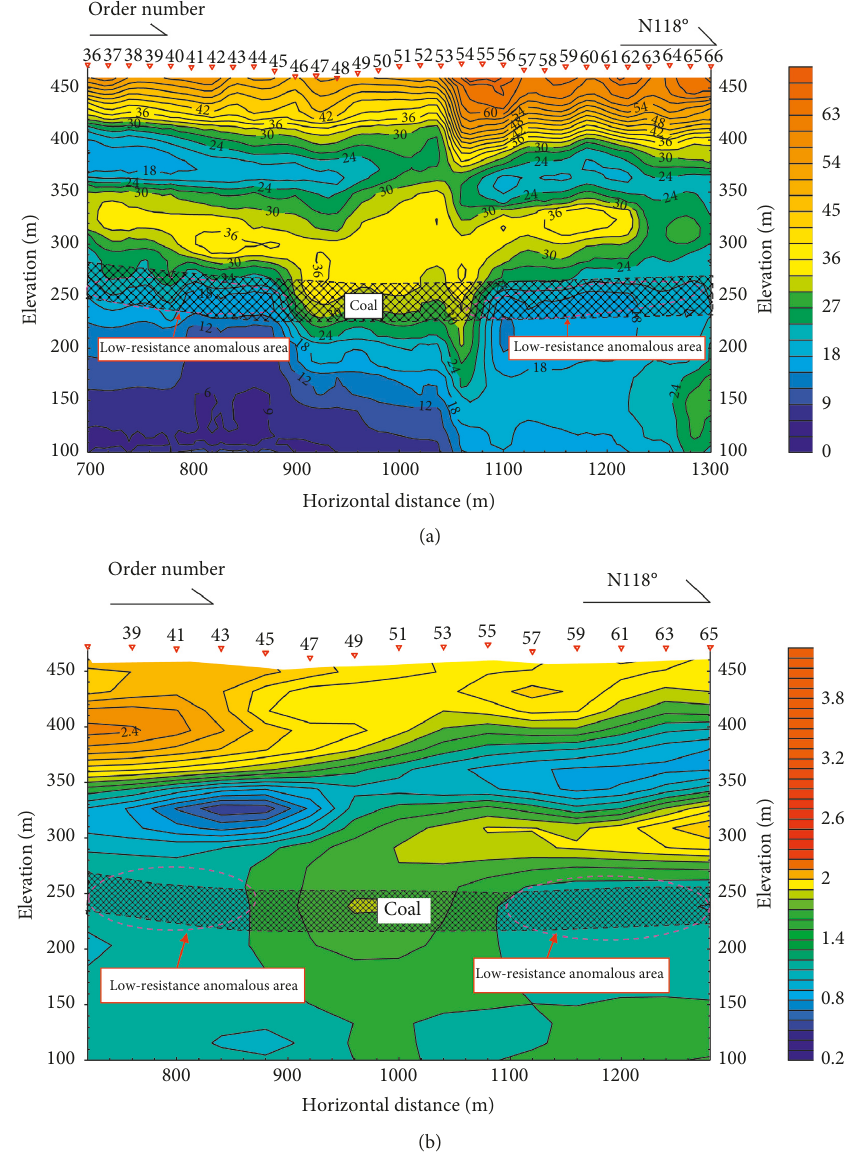
Figure 13: Resistivity sections obtained by different methods. (a) Inversion of the resistivity profile from line 13 of the TEM method. (b) Inversion of the resistivity profile from line 13 of the CSAMT